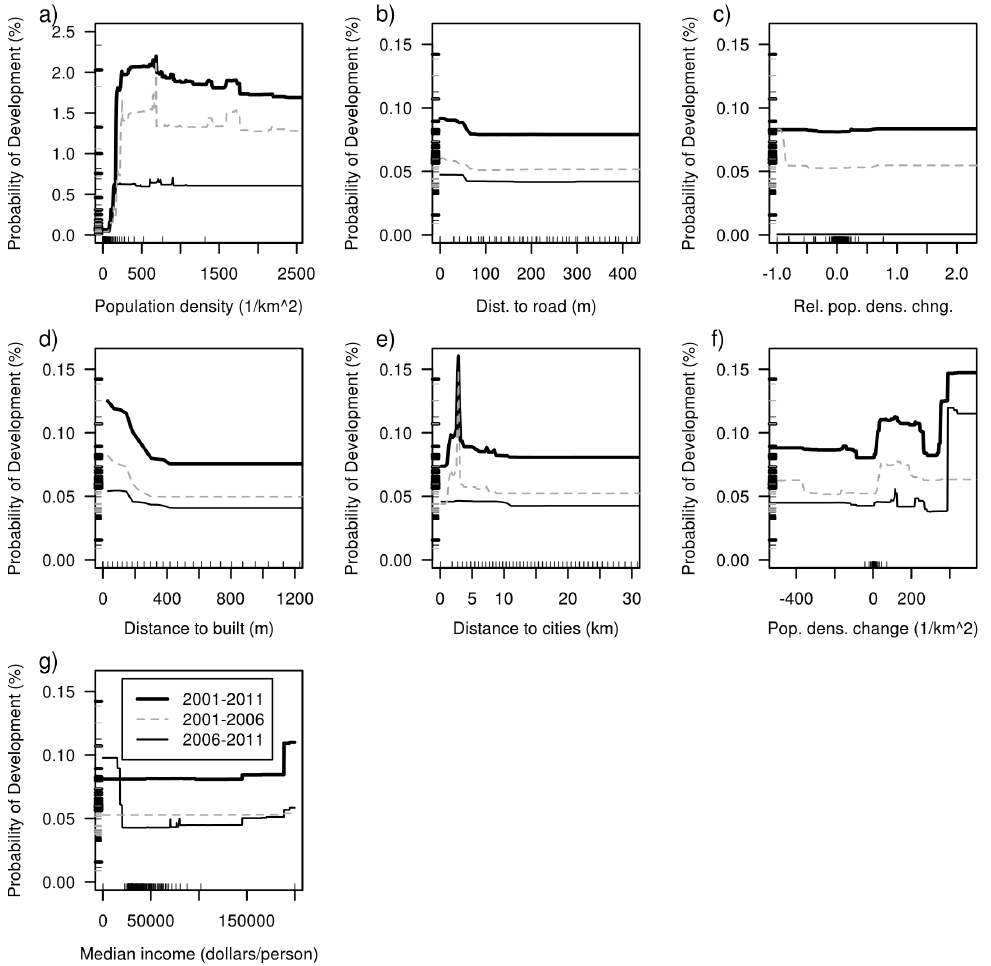
Figure 3. Partial dependency plots of the predicted probability of development with variation in the most important independent variables for BRT models for the full time interval 2001–2011 (thick black) and the two subintervals 2001–2006 (dashed gray) and 2006–2011 (thin black). Plots are shown for ( a ) population density, ( b ) distance to road, ( c ) relative change in population density, ( d ) distance to built, ( e ) distance to cities, ( f ) population density change and ( g ) median income. Rug plots are included on both axes in each plot to show percentiles within the data space for each time interval. X-axis rugs show the distribution of values in the driving variable, and y-axis rugs show the distribution of predicted probabilities for each time interval, using the same style as the graph lines for each interval. Where the percentiles were the same for both time intervals, the rugs overlap. Plots depict only the ranges of the independent variables over which the probability of development showed variation, while percentiles were calculated for the full range of the dataset. Note the greater y-axis range for ( a ) than for the other